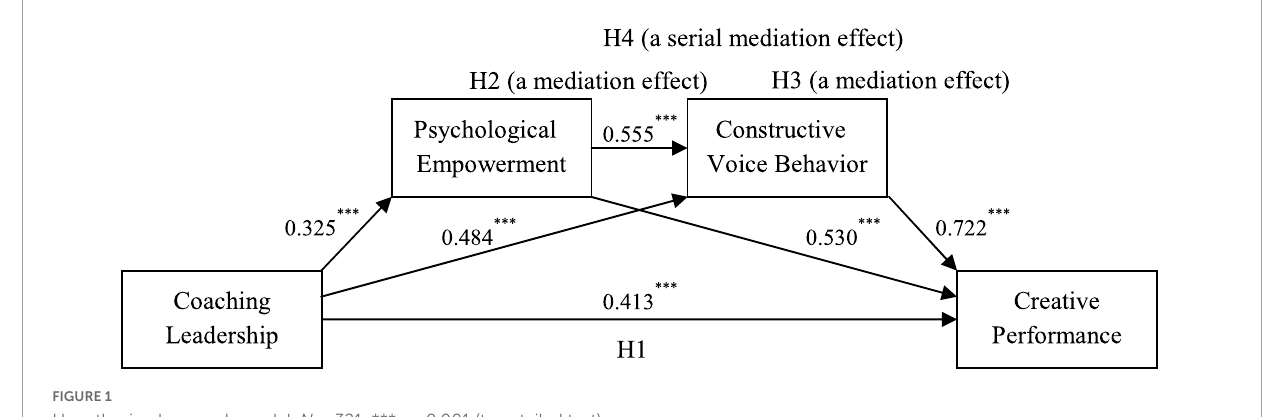
FIGURE1 Hypothesized research model. N = 321. *** p < 0.001 (two-tailed